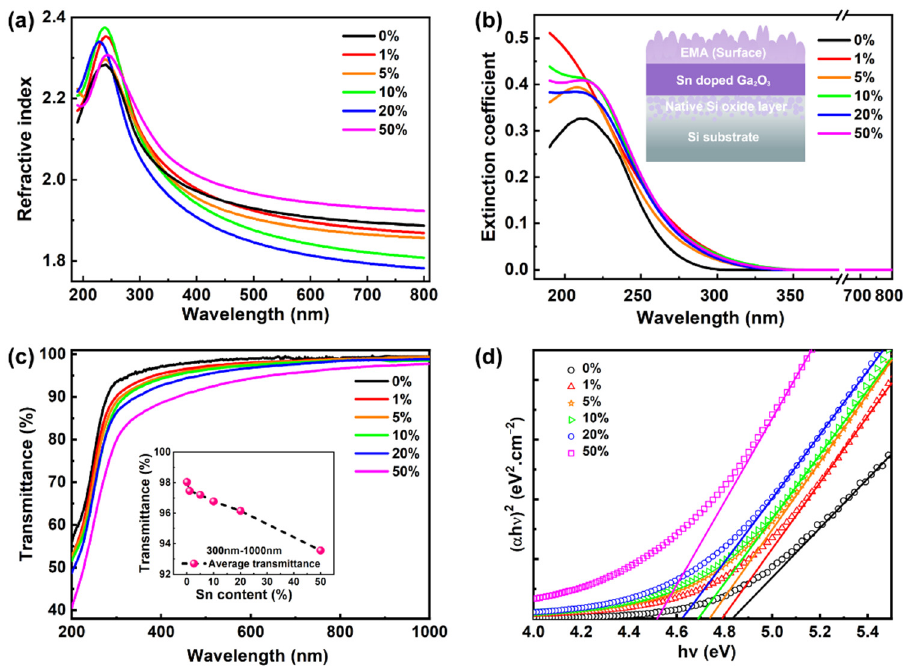
Figure 6. ( a ) Refractive index and ( b ) extinction coefficient for the various Sn-doped Ga 2 O 3 thin films as a function of the wavelength. The inset in ( b ) depicts the schematic representation of the layer structure. ( c ) Transmittance spectra of the as-deposited Ga 2 O 3 film at various contents of Sn. The inset displays the variation in the transmission with the content of Sn. ( d ) The ( α h ν ) 2 vs. h ν curves are determined from the UV–Vis method. The extrapolation of the linear regions to the horizontal axis provides estimates of the E g values.